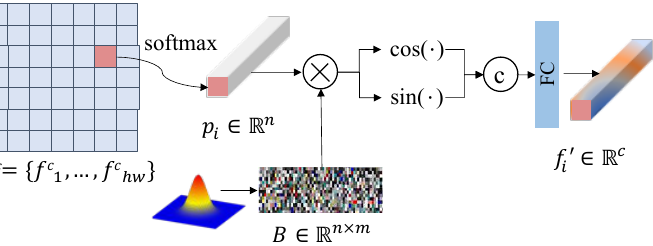
Figure 3. Illustration of feature enhancement. A random Gaussian matrix is employed to enhance the feature discrimination